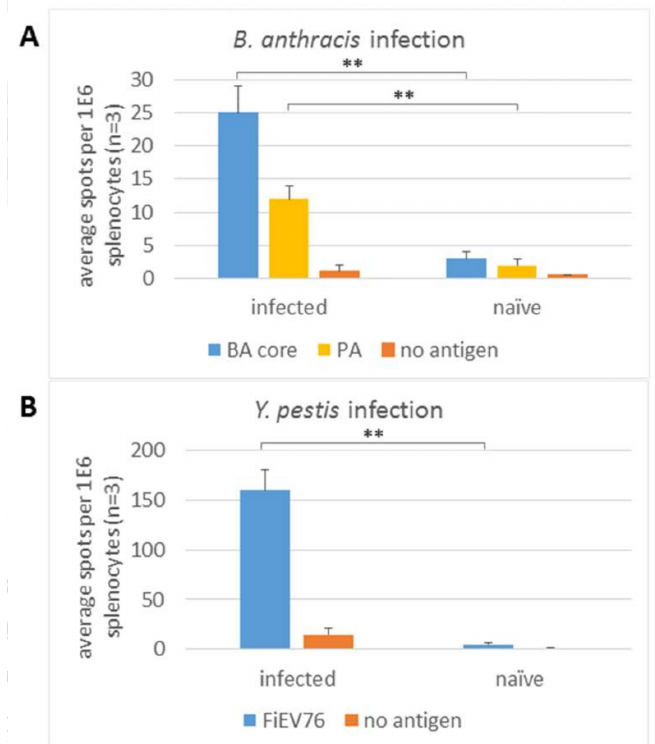
Figure 2. IFN γ ELISPOT response in the spleen following subcutaneous infection with B. anthracis and Y. pestis . Mice were infected with B. anthracis strain Sterne ∆ htrA lefMUT ∆ cya ( A ) or Y. pestis subsp EV76 ( B ). Four days later splenocytes were stimulated with B. anthracis core antigens and PA protein